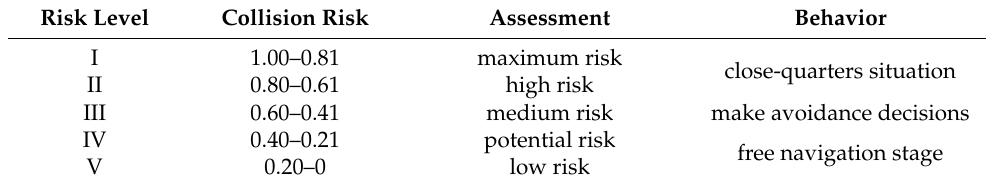
Table 4. Collision risk level.